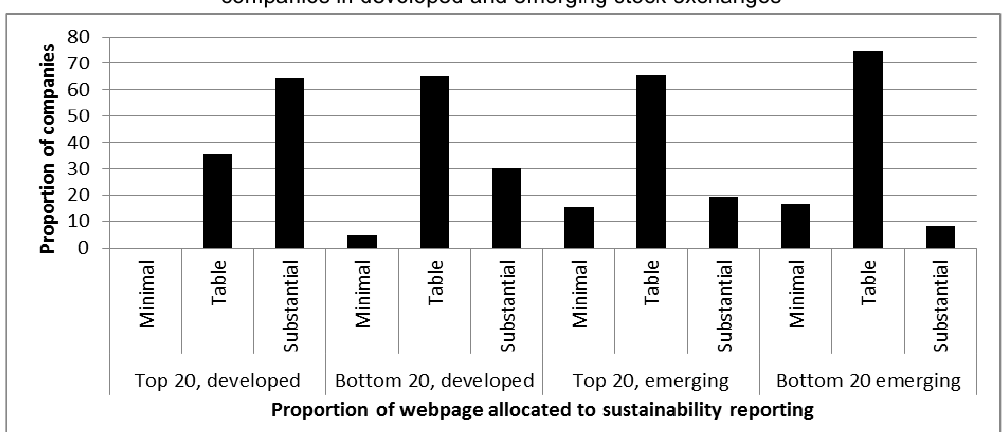
Proportion of webpage allocated to sustainability reporting for the top and bottom 20 listed companies in developed and emerging stock